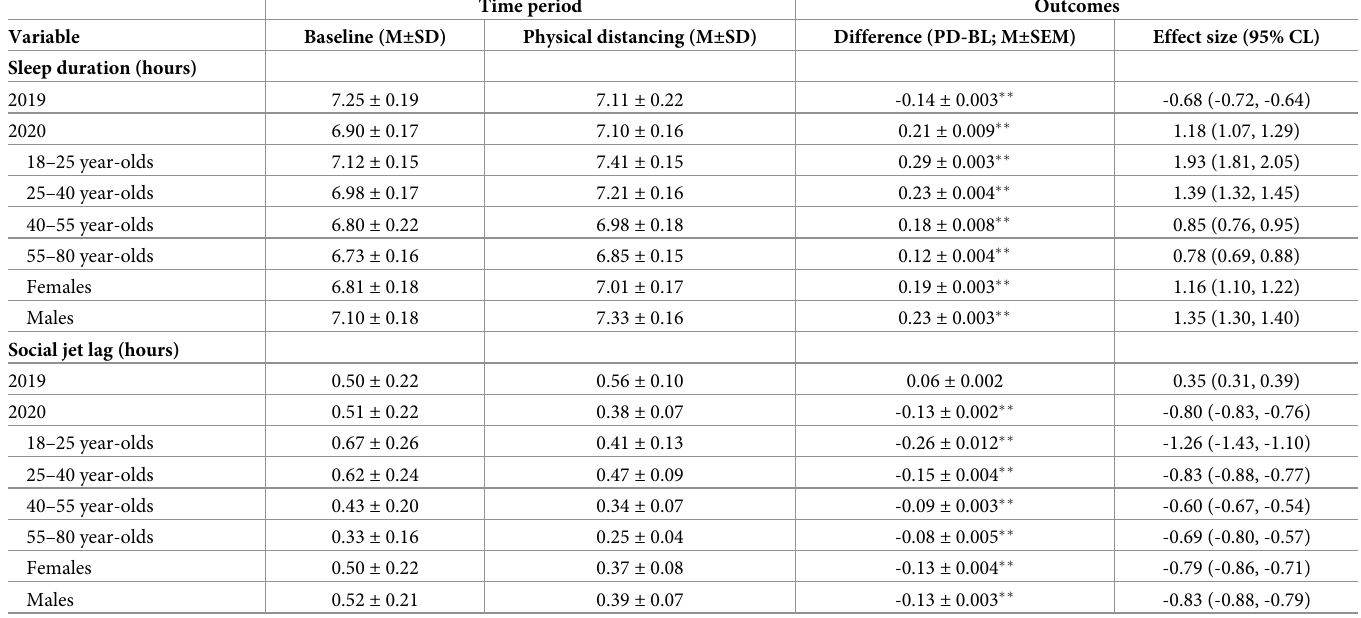
Table 2. Objective sleep outcomes as a function of time